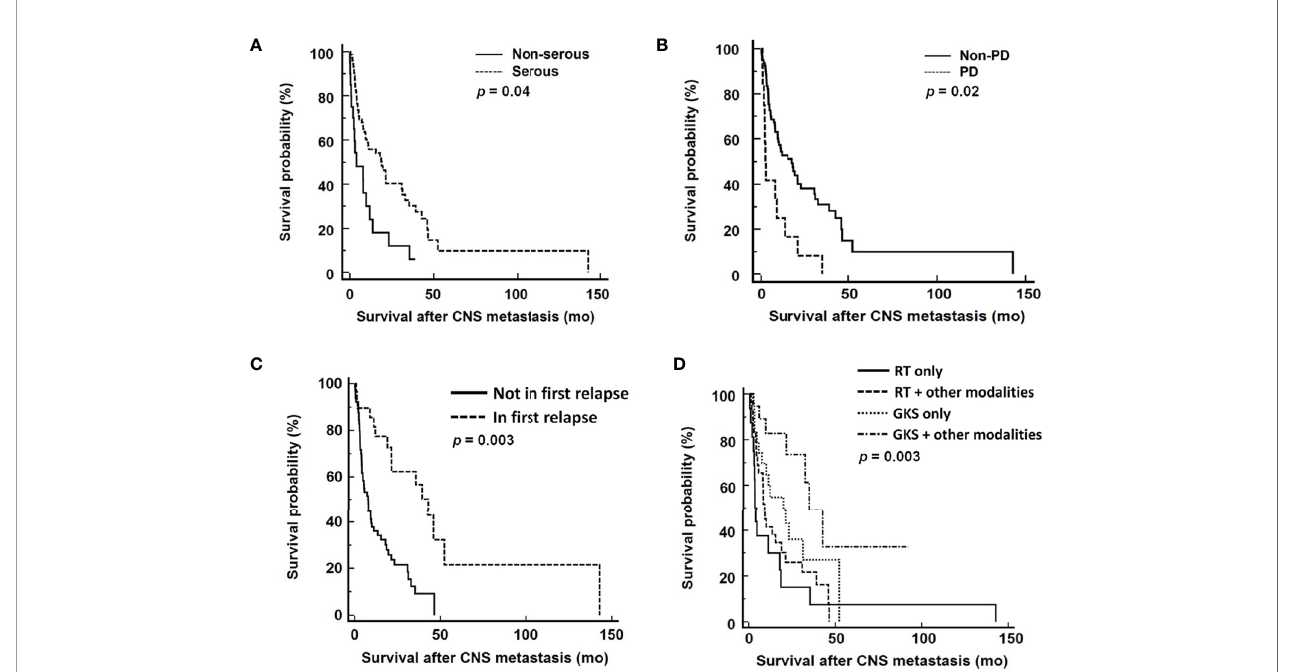
FIGURE 2 | Survival analyses from diagnosis of CNS metastases according to (A) tumor histology, (B) response to primary treatment, (C) CNS involvement in fi rst disease relapse, and (D) different treatment modalities. CNS, central nervous system; PD, progressive disease; RT, radiation therapy; GKS, gamma knife radiosurgery. RT included WBRT and spinal RT.